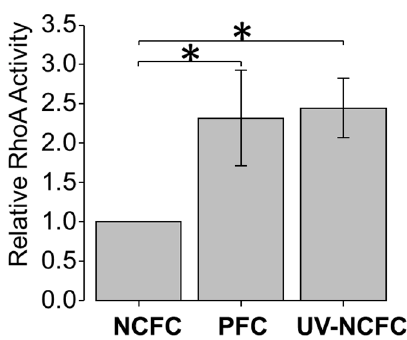
Figure 6. Rho A activation assay for NCFCs, PFCs, and UV-NCFCs ( n = 3). The amount of activated Rho of NCFCs, PFCs, and UV-NCFCs was determined by a pull-down assay. Data shown in the lower panel r epresent the relative change in GTP–Rho. Relative RhoA activity increased significantly in PFCs and UV-NCFCs. Data are shown as mean ± SE, * p < 0.05 and ** p < 0.01 .